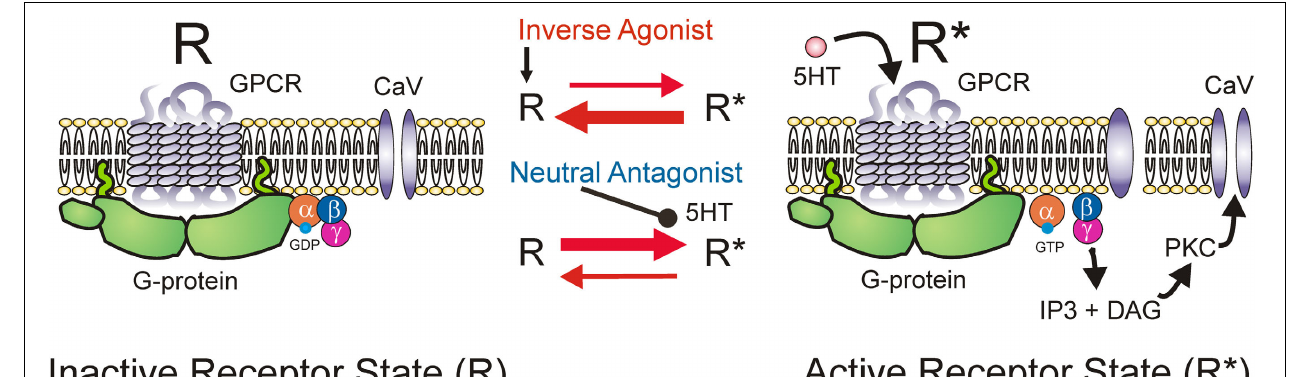
FIGURE 5 | Mechanism of inverse agonists and neutral antagonists. Receptor state equilibrium: Inactive state (R, left panel) of G-protein coupled receptor (GPCR) where α , β , and γ subunits of the G-protein and downstream pathways are not activated. Active receptor state (R ∗ , right panel) where the α -subunit is released by facilitating exchange of GDP for GTP. Dissociated α -subunit activates phospholipase C (PLC, not shown) resulting in the